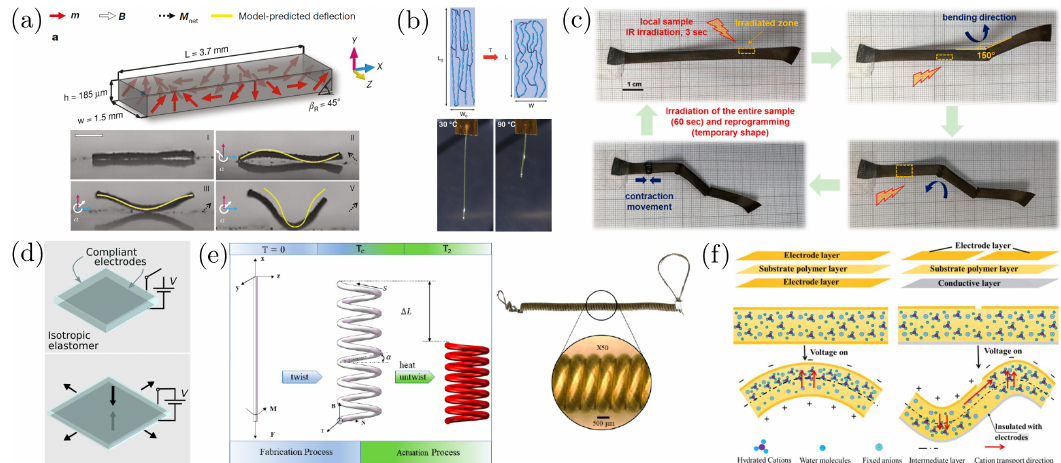
Figure 5. Examples of anisotropic transducers. ( a ) Magnetization profile [72]. Copyright